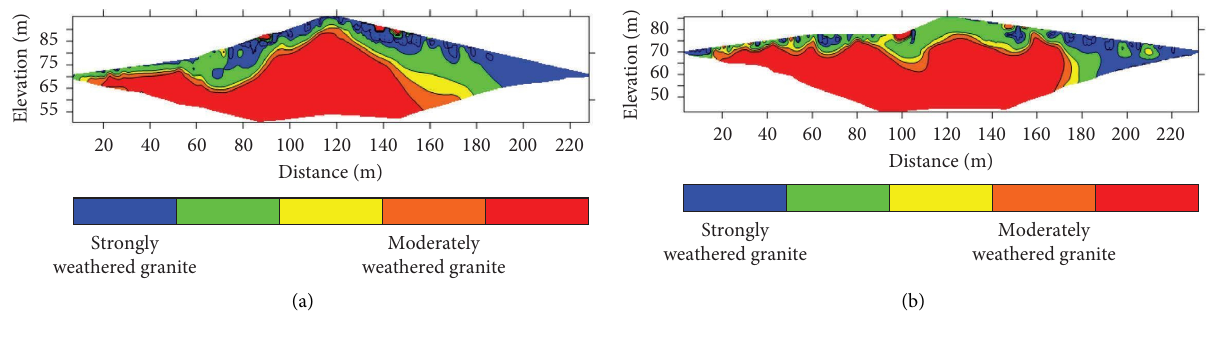
Figure 9: Material segmentation. (a) Line 1. (b) Line